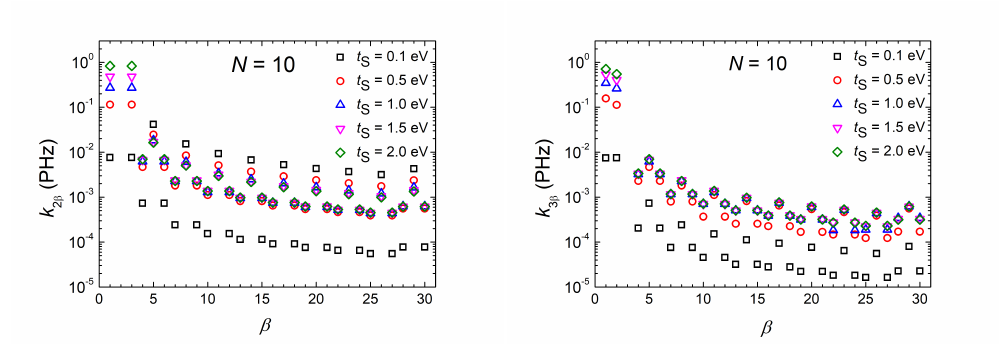
Figure 9. Variation of the mean transfer rates, k αβ , from initial site α = 2 or 3 to sites β = 1, . . . ,30 ( β (cid:54) = α ) for a G... homopolymer made of N = 10 monomers for five values of t S . Left : α = 2. Right : α =